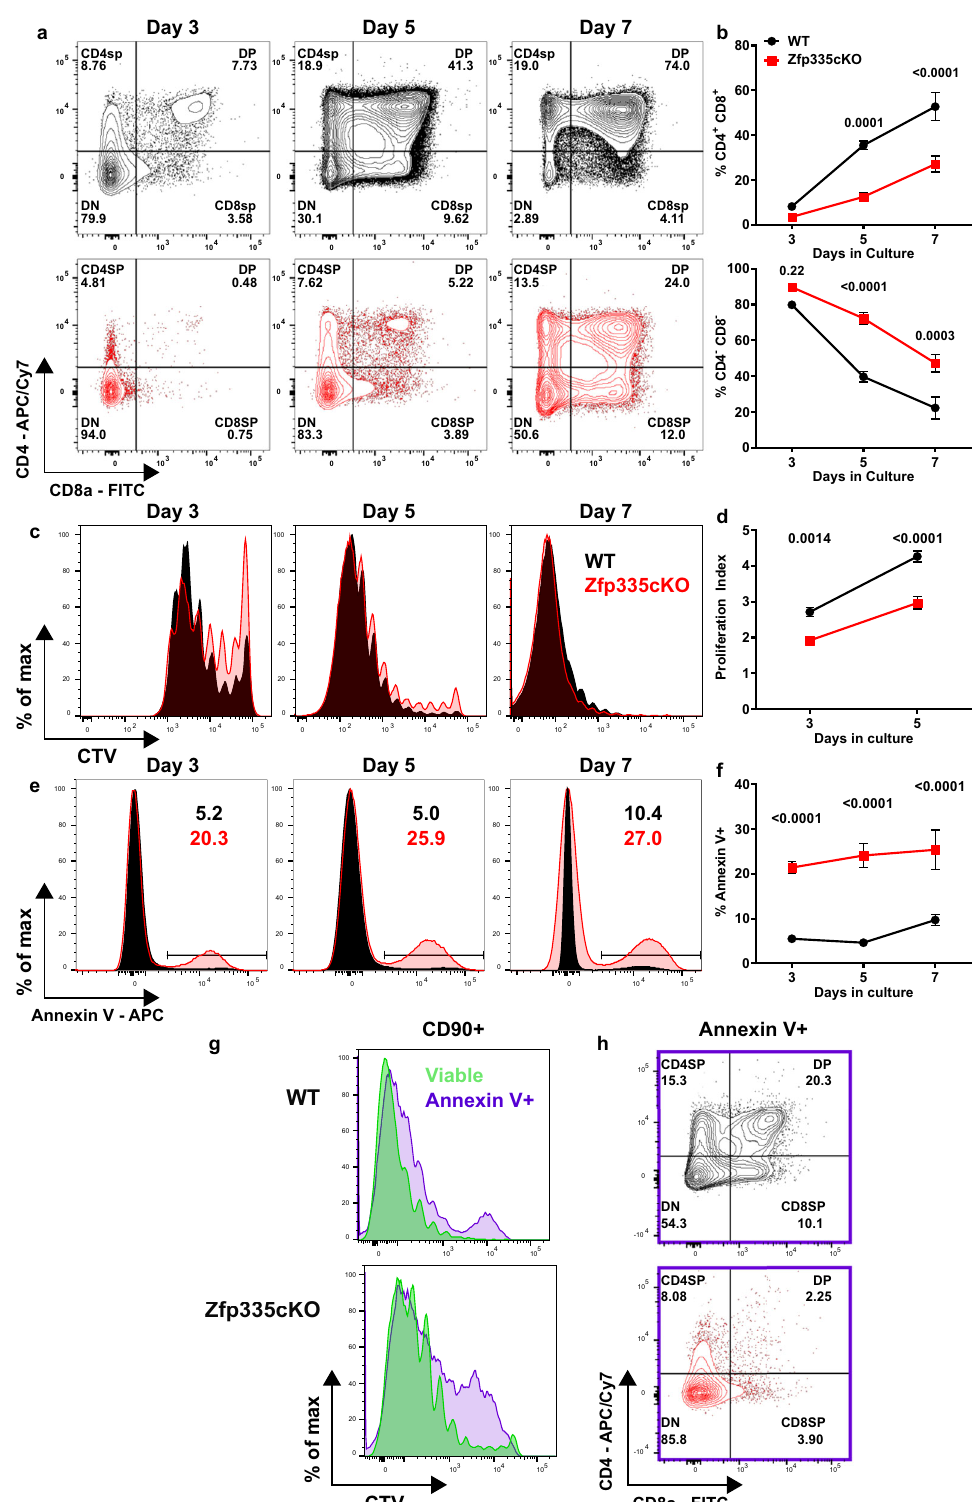
h Representative CD4 vs CD8 expression among Annexin V + cells on day 5 of culture. n =6WTor n =5Zfp335cKOmaleandfemalemicefromthreeindependent experiments. P -values determined using two-way repeated-measures ANOVA with posthocSidak ’ stest.Plotsshowmean±SEM.SourcedataareprovidedasaSource Data fi